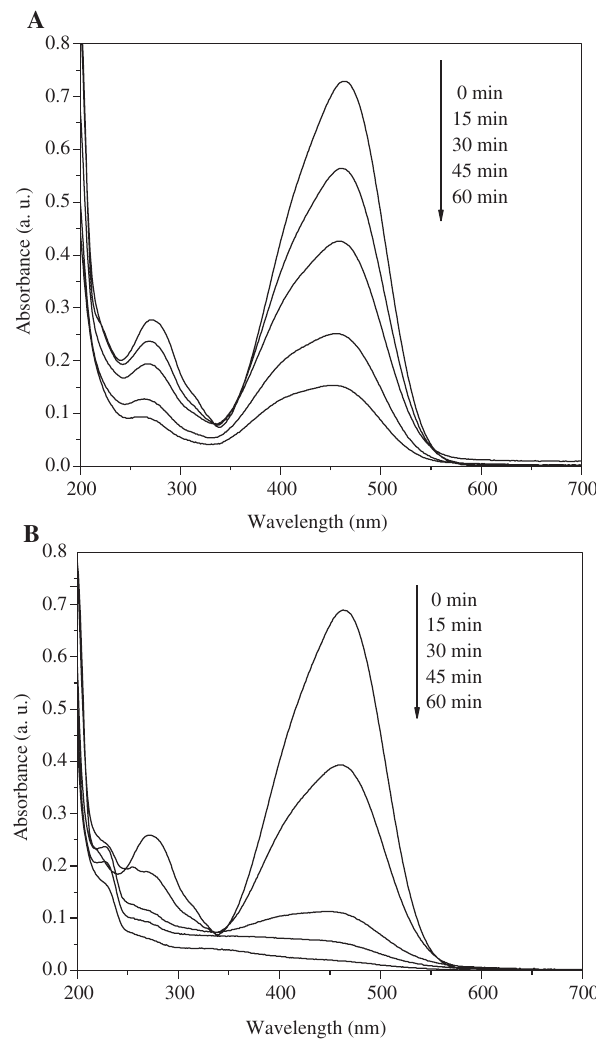
Figure 8: UV-Vis absorption spectra of methyl orange aqueous solu- tion catalyzed by (A) 0.05%Sm-TiO